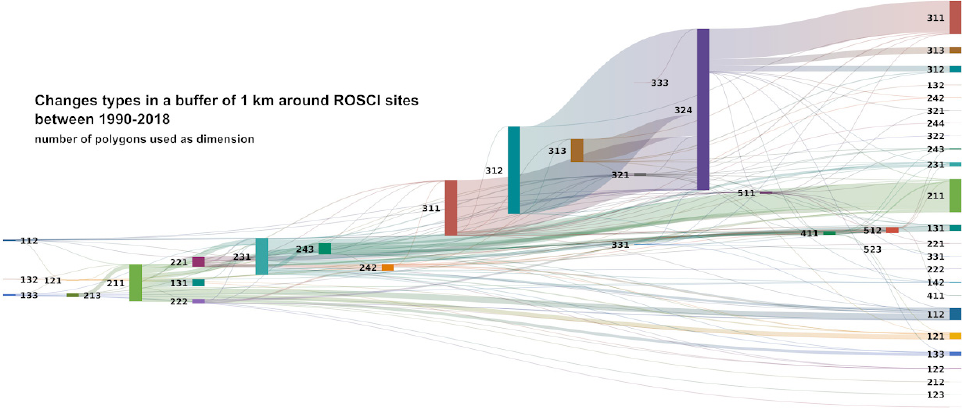
Figure 14. Land cover change dynamic in buffer of ROSCI sites, between 1990–2018.